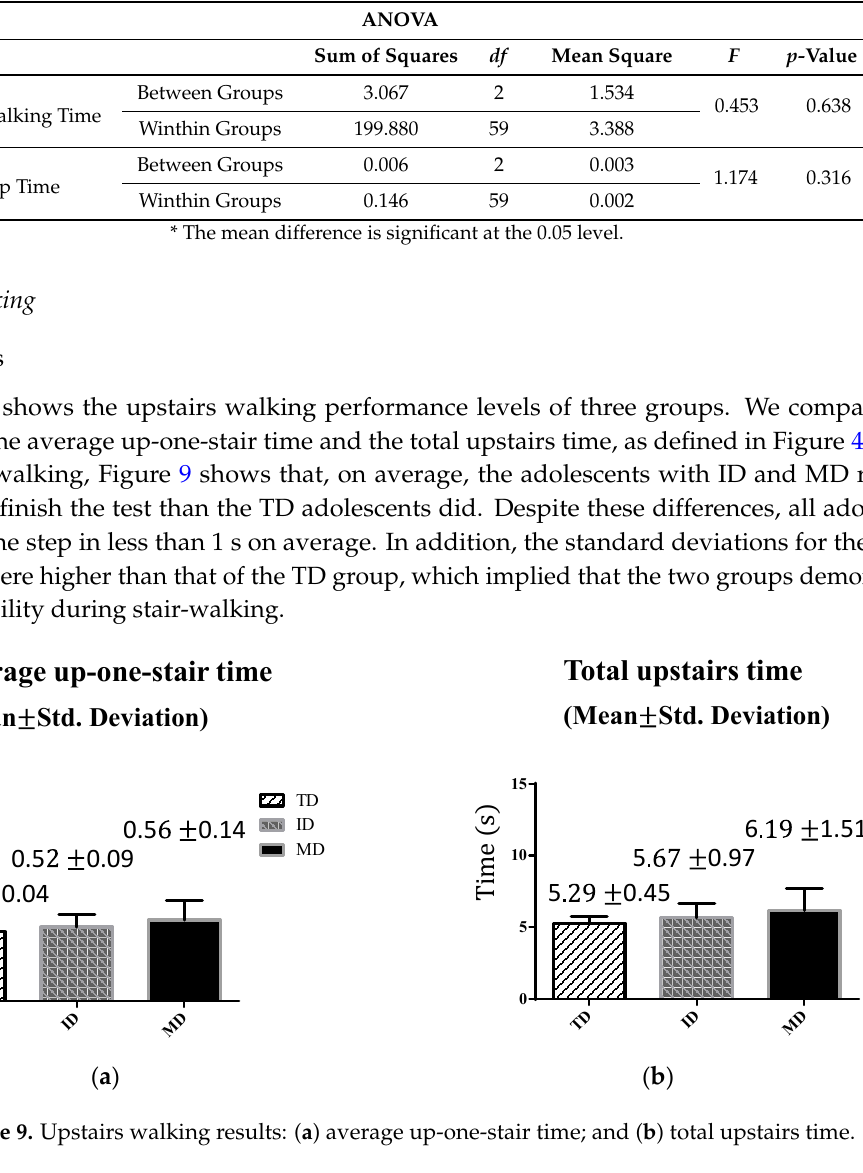
Table 3. ANOVA test of upstairs walking for three groups. ANOVA Sum of Squares